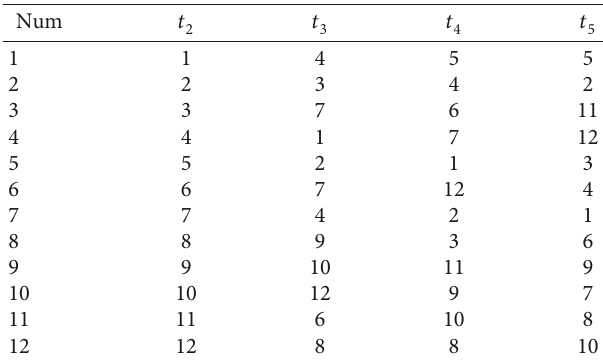
Table 1: Uniform design table.